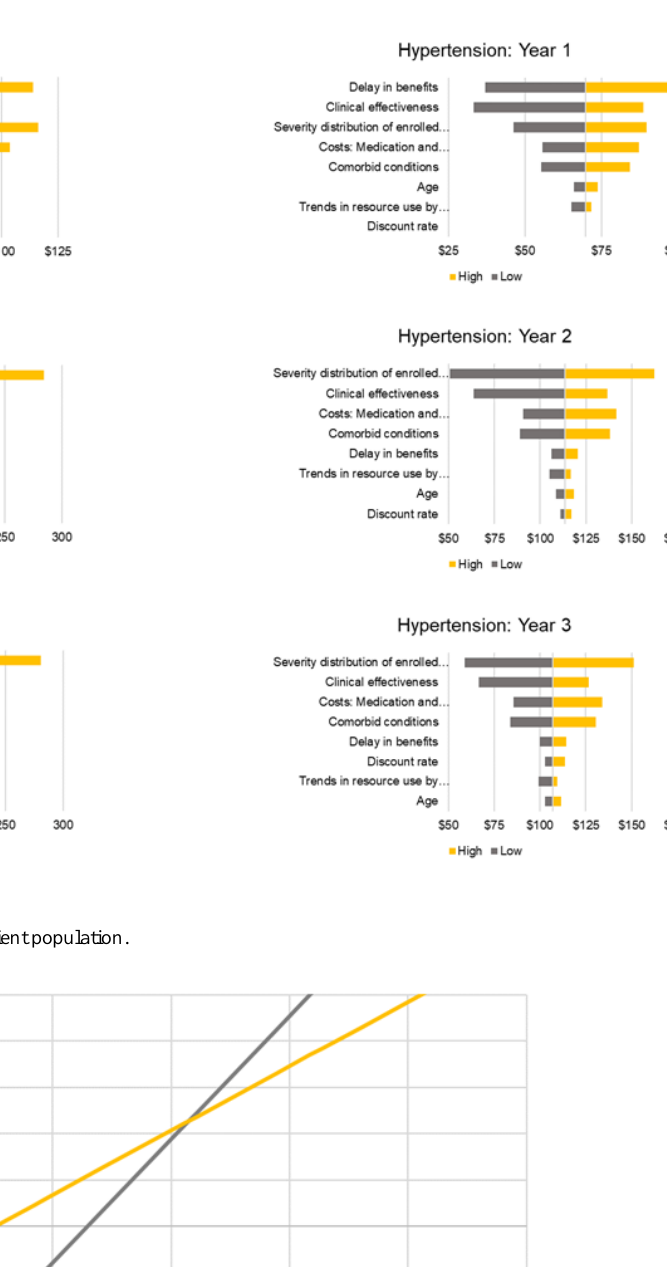
Figure 3. Health resource use sensitivity analysis by patient population.